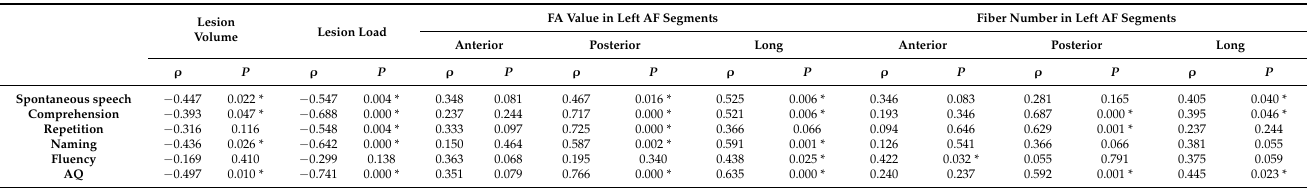
Figure 3. The partial correlation analyses of the PSAF and LSAF and language subsets (controlled variable: lesion load). * Statistical significance level: α = 0.05. Table 2. The correlation analyses between language performance and MRI measures.